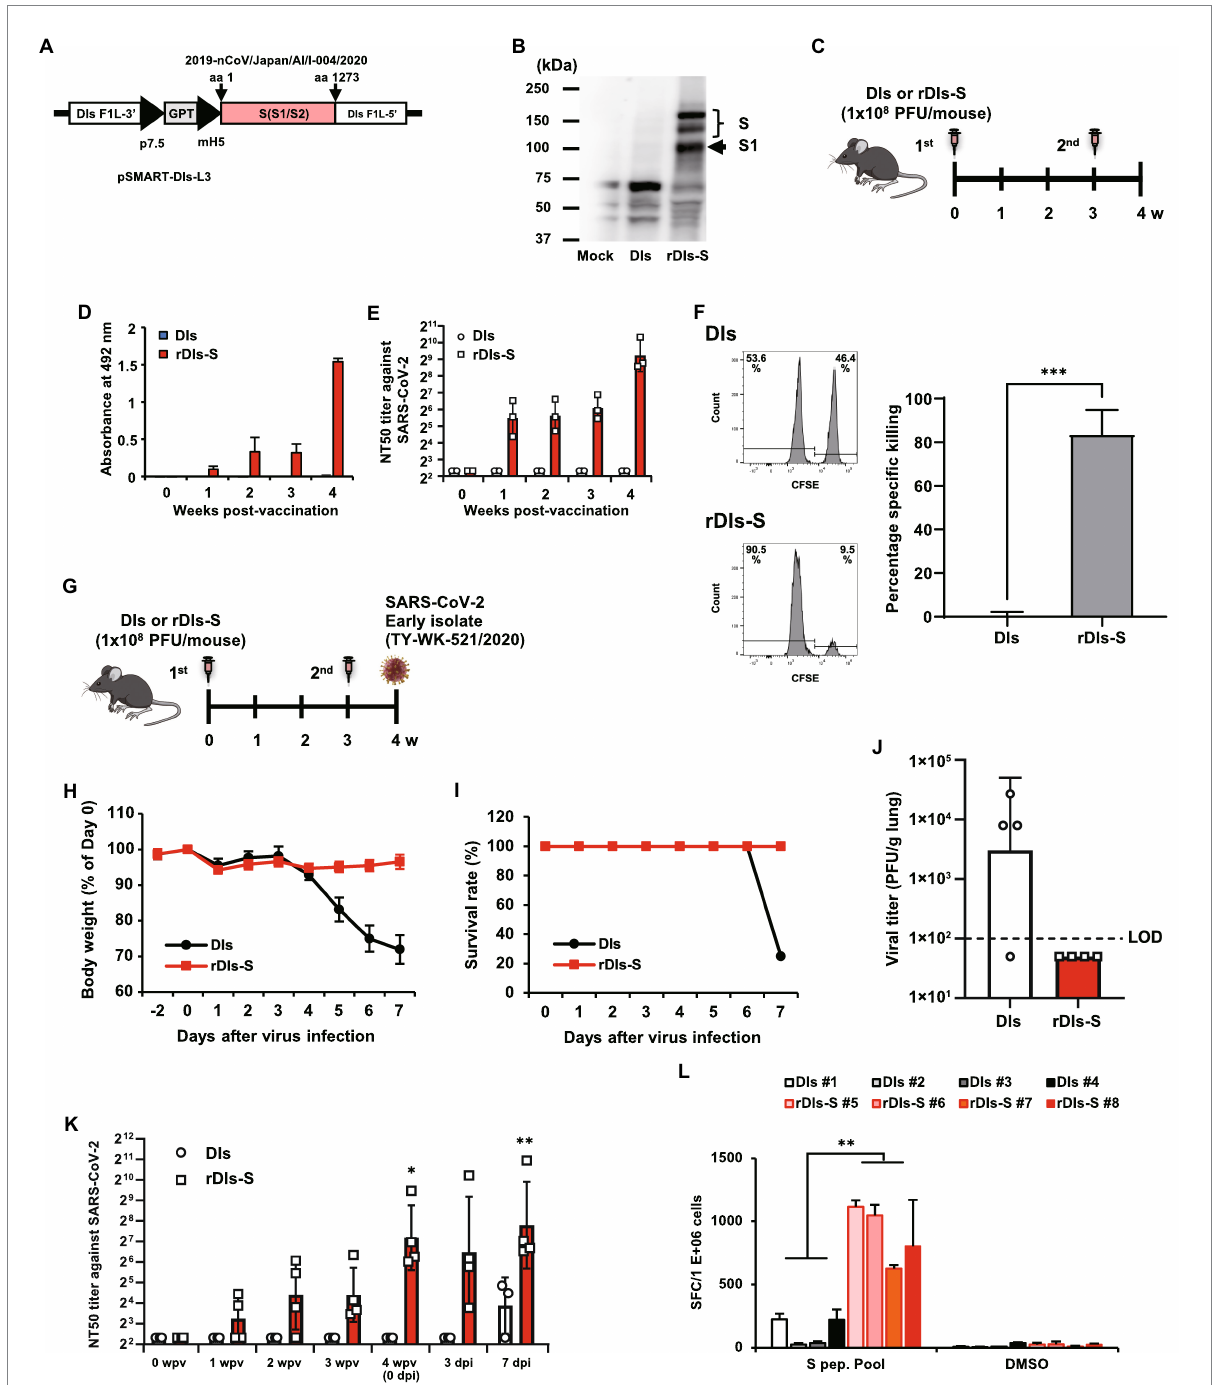
FIGURE 1 Immunization with rDIs-S induces both cellular and humoral immune responses. (A) Construction of the plasmid vector used for generating rDIs-S. (B) Expression of SARS-CoV-2 S protein as detected by western blot analysis. (C) Vaccination schedule in C57BL/6 J mice. Nine- to 10-week- old C57BL/6 J mice were inoculated twice intradermally with 1 × 10 8 PFU of rDIs-S or DIs with a 3-week interval. (D) Time course of the production of IgG specific for SARS-CoV-2 S protein as measured by ELISA ( n = 3 per group). (E) Temporal changes in the neutralization titer against the SARS-CoV-2 WK-521 strain ( n = 3 per group). (F) An in vivo CTL assay specific for SARS-CoV-2 S protein peptides. The left panels are representative flow cytometry histograms. The right graph shows the mean ± SD of the specific killing of target cells ( n = 3 per group). Value of p s was calculated using a two-tailed non-paired Student’s t -test *** p < 0.001. DIs, vaccinia virus DIs strain; rDIs-S, recombinant DIs carrying S gene of SARS-CoV-2; PFU, plaque-forming unit; CTL, cytotoxic T lymphocyte; GPT, gene-encoding xanthine-guanine phosphoribosyltransferase; p7.5, vaccinia virus early promoter; ELISA, enzyme-linked immunosorbent assay; hACE2, human angiotensin-converting enzyme 2; SD, standard deviation. (G) Experimental schedule in hACE2 transgenic mice. Six-to 10-week-old hACE2 transgenic mice were inoculated twice intradermally with 1 × 10 8 PFU of rDIs-S or DIs with